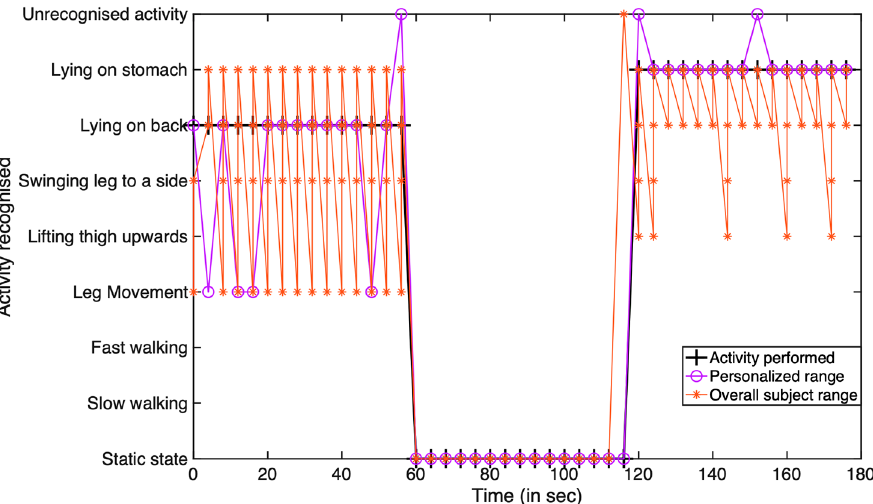
Figure 6 . Long-term group-based activity performed (LOB, static and LOS) recognition accuracy comparative analysis with respect to personalized and overall subject ranges.